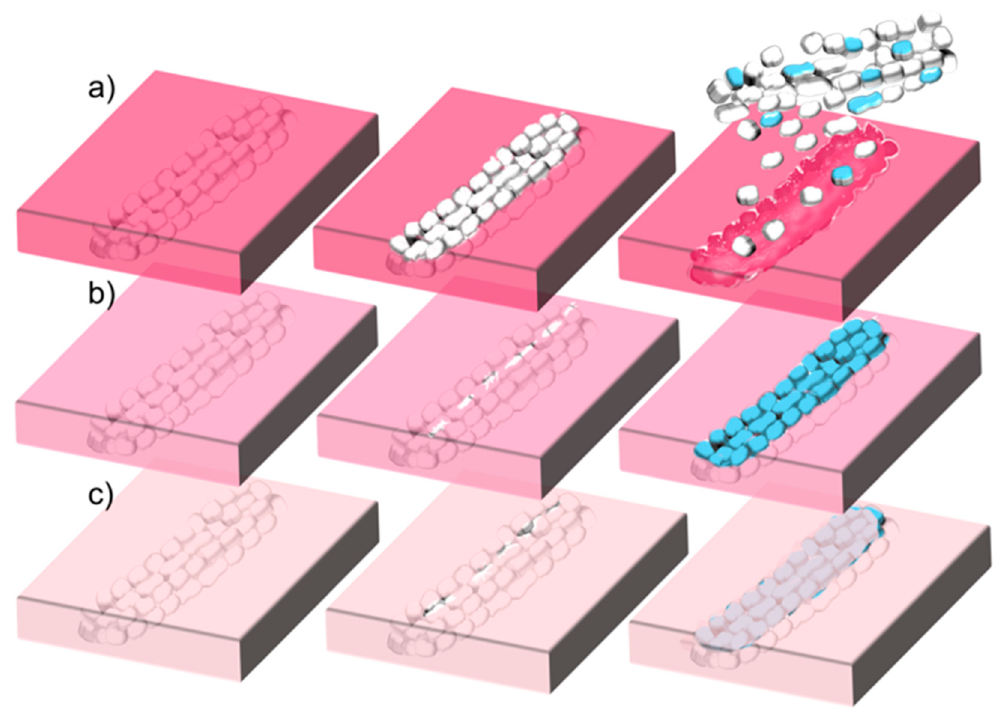
Figure 8. Schematic representation of the differences in the degradation behaviour that lead to different antibacterial efficiencies of the different MgO/polymer composites: ( a ) MgO/PLGA, ( b ) MgO/PLA and ( c ) MgO/PCL. Three stages are shown from left to right: before exposure to physiological solution, after short exposure (2–4 h) and after 1 day exposure. White nanotextured MR is composed of the active MgO, whereas the blue colour represents the less active hydroxide phase.